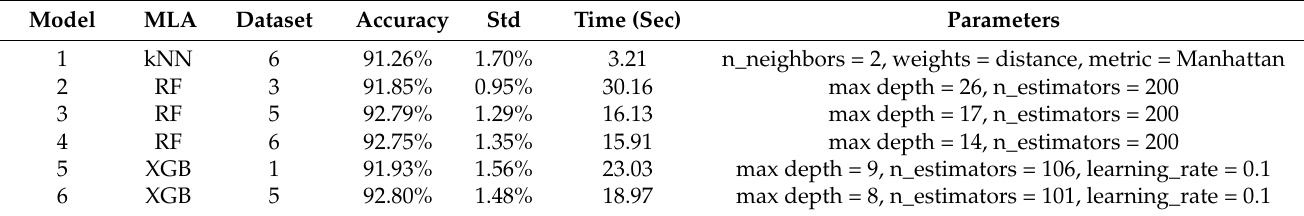
Table 11. Performance improvement of the models after hyperparameter tuning (first improvement procedure).